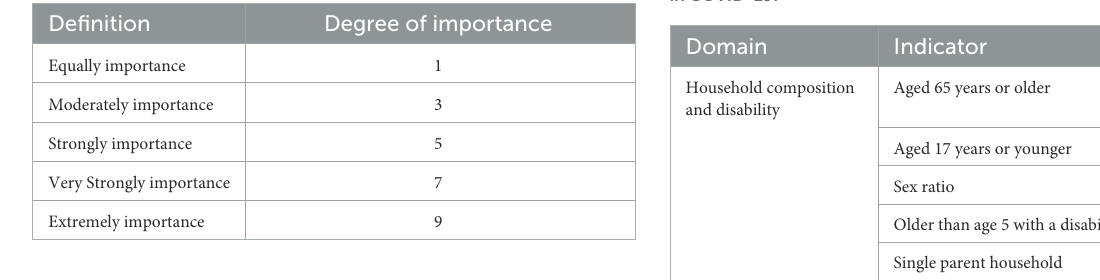
TABLE 1 The nine-point scale and description of its items. TABLE 2 Finalized domains and relevant indicators of social vulnerability in